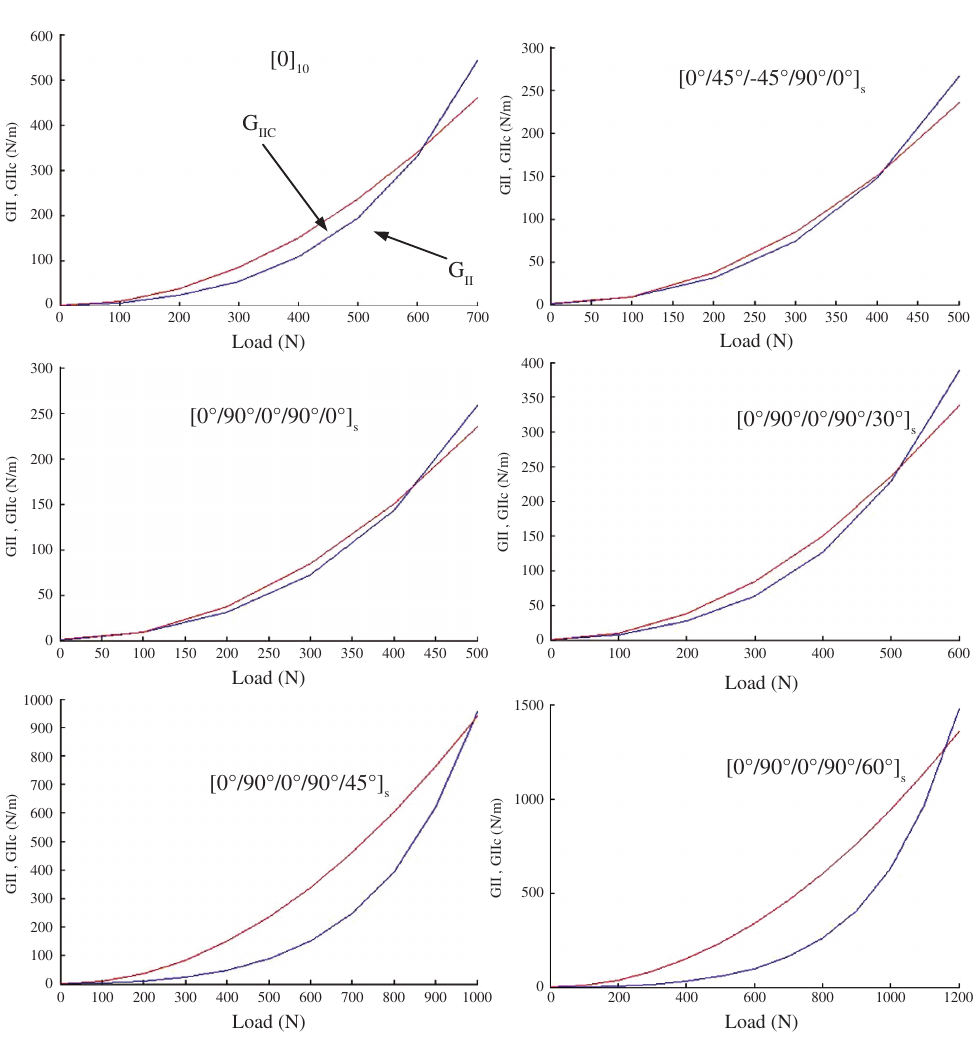
Figure 5 Energy release rate-load diagram for Kevlar/epoxy (Aramid149/epoxy) obtained from meshfree